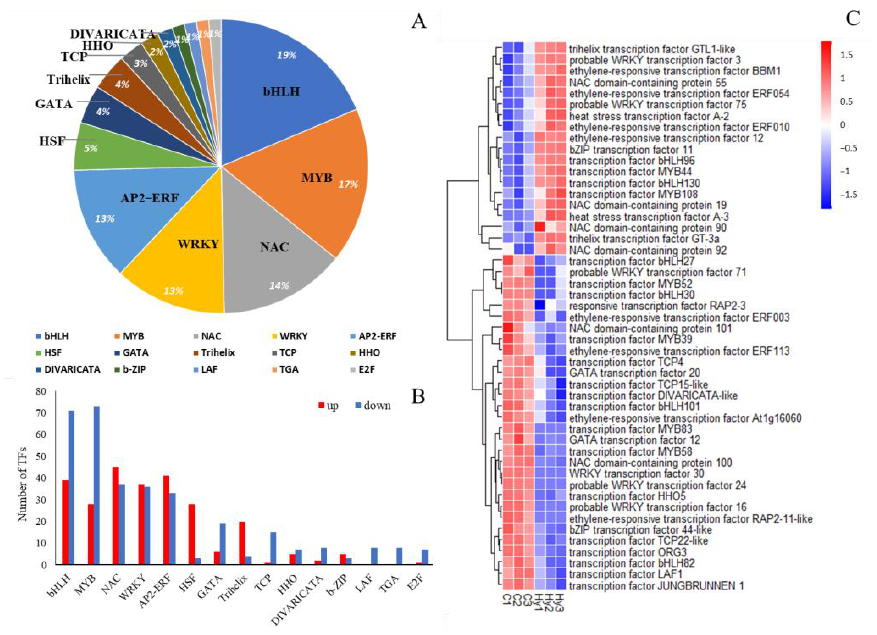
Figure 8. The analysis of differentially expressed transcription factors (TFs) in 3 days of hypoxia- treated roots. ( A ) The pie chart presents the percentage of 15 different families’ categories of tran- scription factors. TFs less than 1% of the total are not marked. Differentially expressed TFs in drought stress. ( B ) The distribution of transcription factors in upregulated and downregulated TF families. ( C ) The heatmap transcript profiles of selected transcription factor genes related to hypoxia response in B. napus roots. Columns and rows in the heatmap represent samples and genes, respec- tively. Sample names are displayed below the heatmaps. The color bar is the scale for the expression levels of each gene.